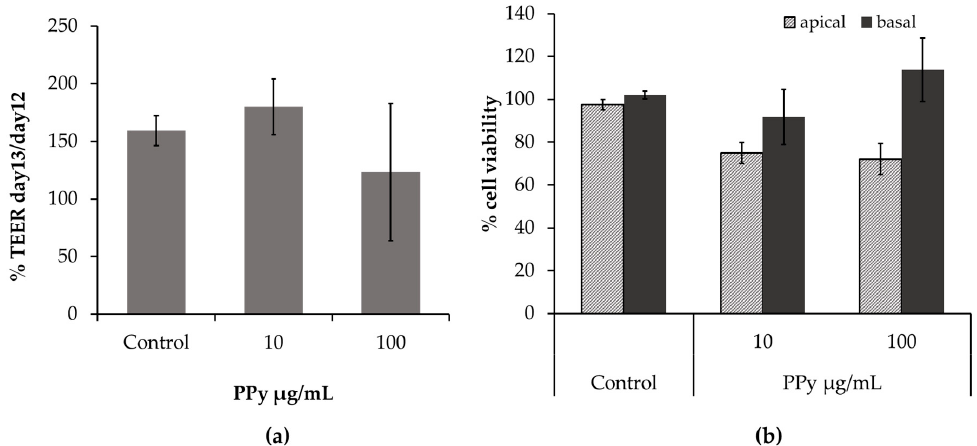
Figure 5. In vitro ABB model integrity. ( a ) TEER of the ABB model after exposure for 24 h to PPy NPs (10 and 100 µg/mL). TEER values were expressed as ratio % between TEER values on day 13 and values on day 12. ( b ) Cell viability of the upper (apical) and lower (basal) compartments of the inserts after exposure to PPy NPs was assessed through the Alamar Blue assay. Data are expressed as relative decrease compared to control (untreated cells), considered as 100% of viable cells. Results represent the mean ± SE of three independent experiments ( n = 3).